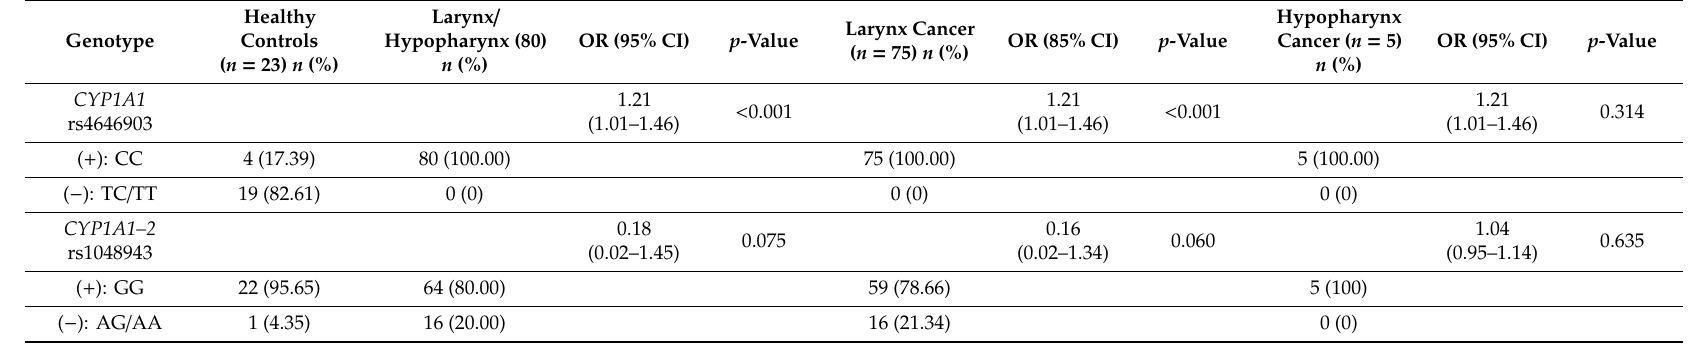
Table 5. Distribution of genotypes of CYP1A1 and CYP1A1–2 polymorphism among healthy controls and patients with larynx or pharynx cancer (Pearson χ 2 test).